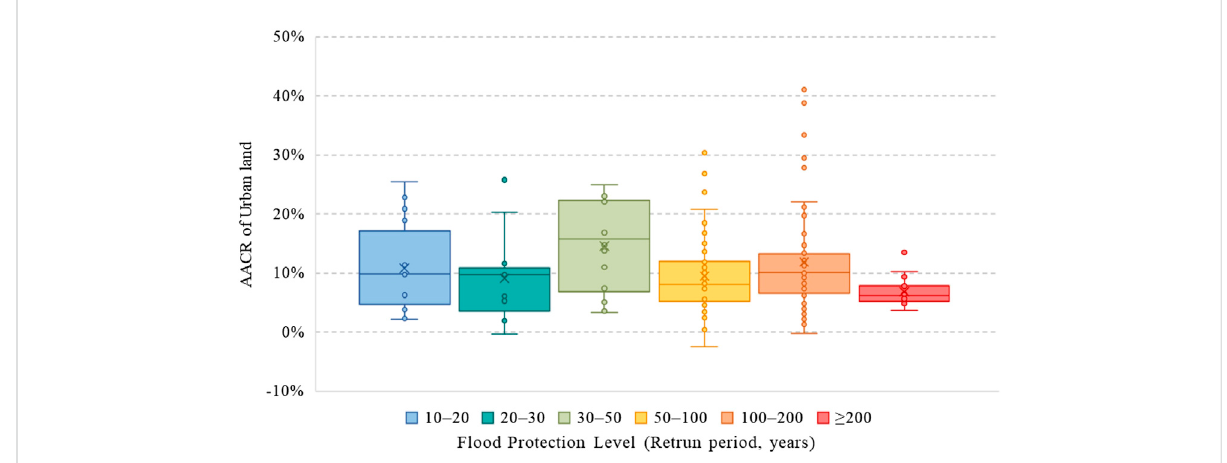
FIGURE 3 The average annual change rates (AACR) of urban lands in CFAs under different FPLs during 2000 – 2020 in China.